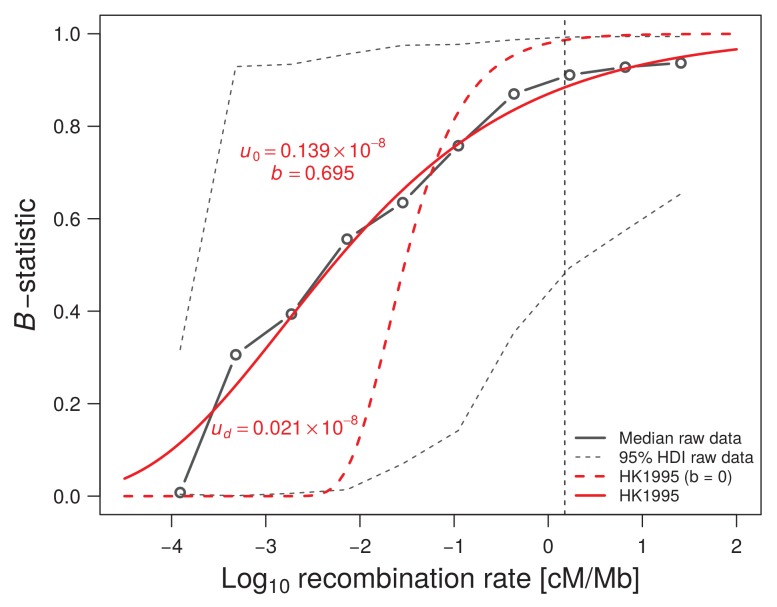
Influence of recombination on diversity (B-statistic).McVicker et al. (2009) median B-statistics are reported as a function of recombination rate (solid black line). The observed data is fitted either under Hudson and Kaplan (1995) simple model of background selection (BGS) with B=exp(−ud/r), where ud is the genome-wide constant deleterious mutation rate, and r is the recombination rate in cM/Mb (red dashed line), or by allowing a log-log linear dependence of the deleterious mutation rate on the recombination rate as ud=u0rb (solid red line). The existence of a correlation between mutation and recombination considerably improves the fit to the B-statistics and thus better explains the signature of background selection (BGS) in the human genome. The vertical black dashed line indicates the recombination rate of 1.5 cM/Mb that we used as an approximate threshold to define our set of neutrally evolving SNPs in the remainder of the study. Note that this threshold also marks the beginning of a plateau for the observed B-statistics.